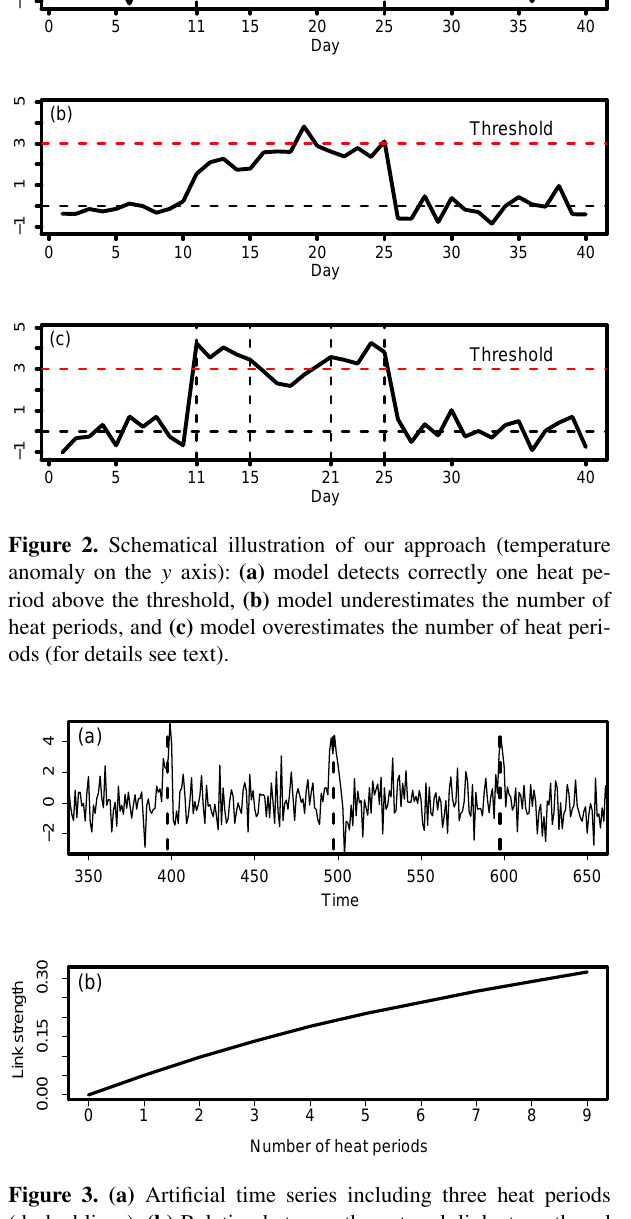
heat period has actually occurred in Fig. 2a–c persisting for 15days from day 11 to day 25. Accordingly the black curves show different possible model results if the model exhibits predictive skill to detect a signal out of the noise. Figure 2a depicts that using the standard approach the model correctly detects one heat period above the